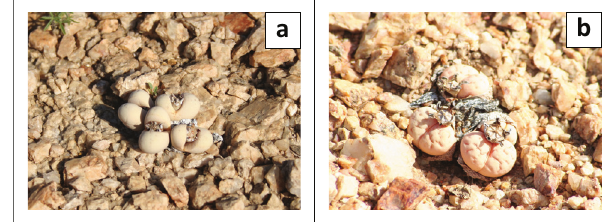
FIGURE 1: Plants of Lithops ruschiorum showing (a) a healthy plant in profile with the fissure clearly visible and developing capsules in a feldspar habitat and (b) a healthy plant with old leaves in the centre and three ripe, 6–7-locular seed capsules in a mixed gravel